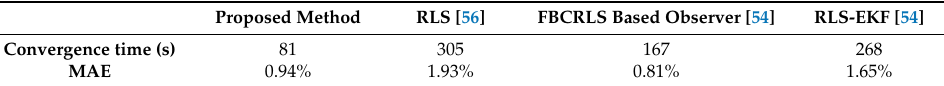
Table 2. CPU time comparison of the proposed and other methodologies.